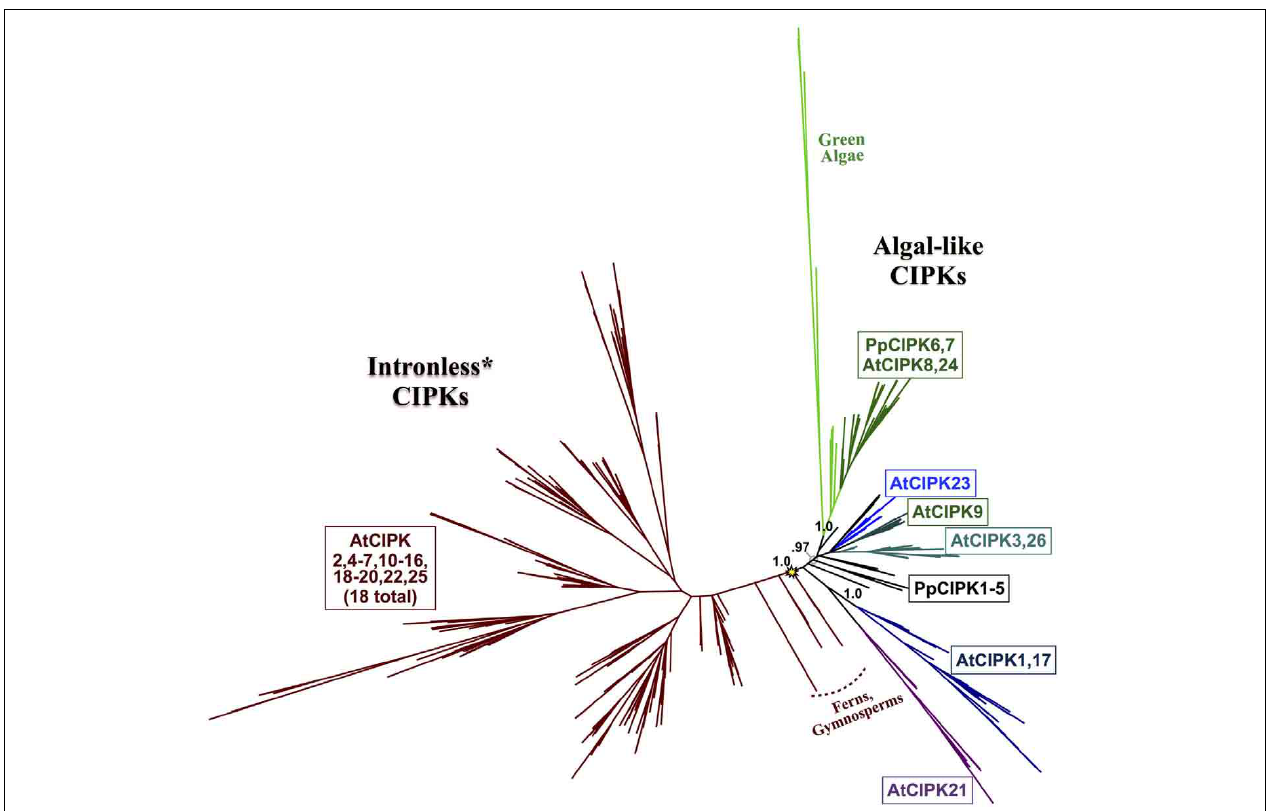
FIGURE 8 | ML phylogenetic tree derived from protein MSA of all CIPKs identified in this study. Confidence scores (aLRT) are shown for select clades. CIPKs from green algae phylogenetically cluster with land plant CIPKs, including Physcomitrella CIPK6 and CIPK7. Remaining Physcomitrella CIPKs cluster with Arabidopsis CIPK1, 17, and 21, which contain multiple